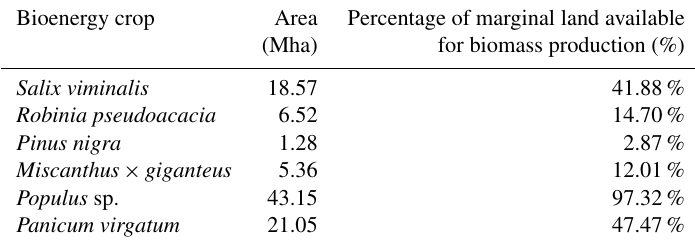
Figure 12. Marginal land suitability for bioenergy crops. Table 8. Marginal lands available for biomass production per bioenergy